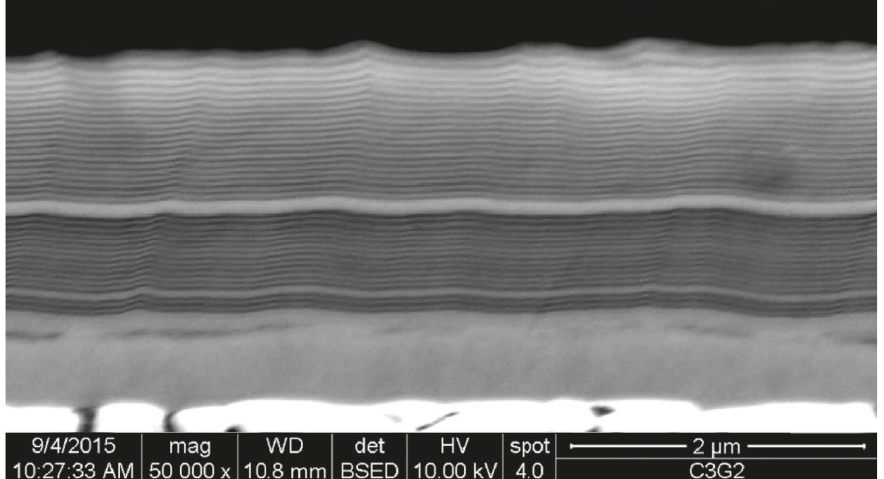
Figure 3: The microstructure of the NMCC Zr-ZrN-(ZrCrAl)N on the transversal cross section. The thickness of the nanolayers is 15–45nm; the total coating thickness is 2.44 μ m